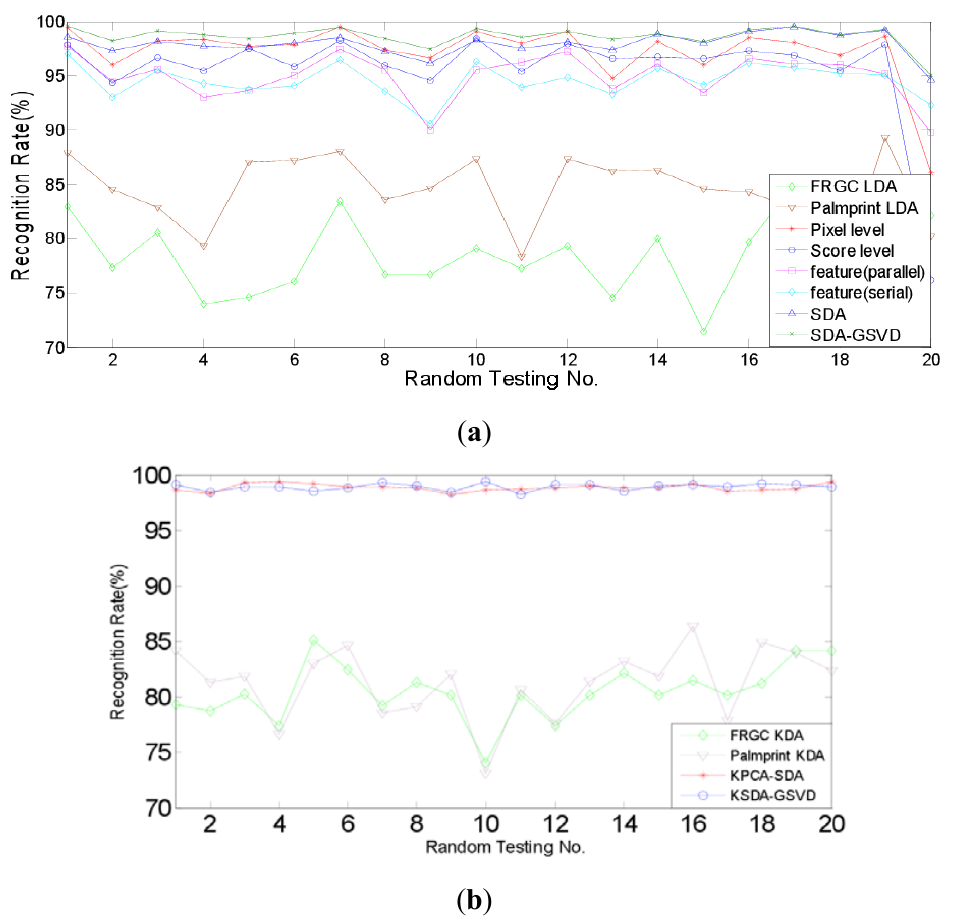
Figure 7. Recognition rates of compared methods on FRGC face and PolyU palmprint databases: ( a ) Linear methods; ( b ) Nonlinear methods.